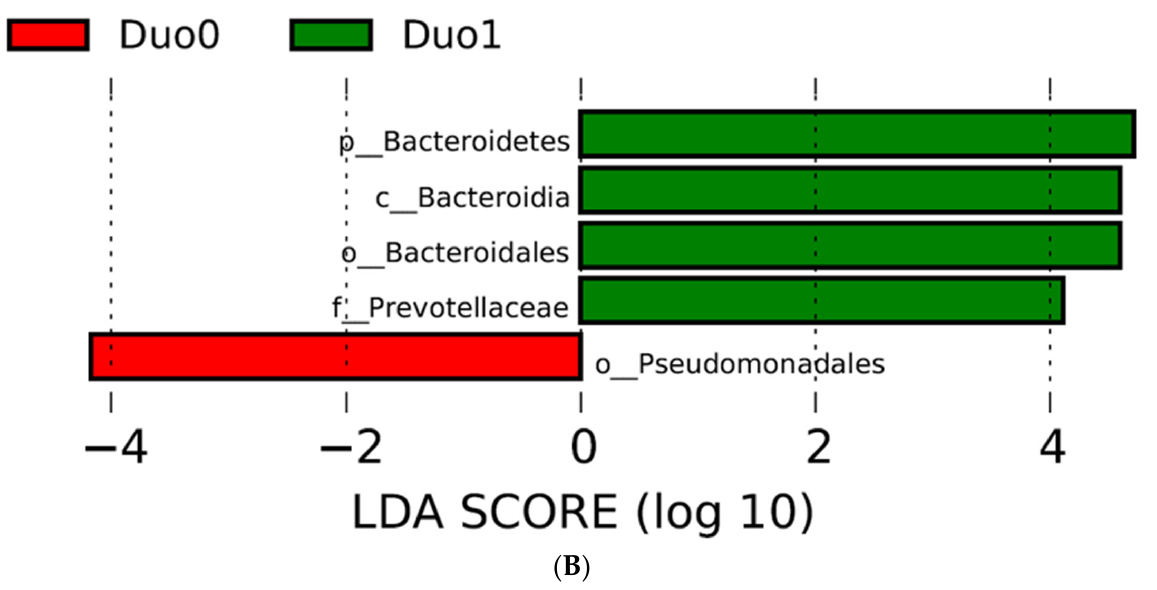
Figure 1. Linear Discriminant Analysis effect size (LEfSe) comparing relative bacterial composition in the duodenum between controls (Duo0, red) and children with active Crohn’s disease in the duodenum (Duo1, green). ( A ) The cladogram compares differences between bacterial entities in the duodena of controls and children with active Crohn’s Disease (CD). Innermost nodes represent the phylum level of classification and move outward to class, order, family and genus. Yellow nodes denote bacterial entities that were not significantly different between the two duodenal study groups. ( B ) Bar graph with log 10 transformed Linear Discriminant Analysis (LDA) scores that numerically compares the most abundant bacterial taxa between controls and children with active duodenal CD.